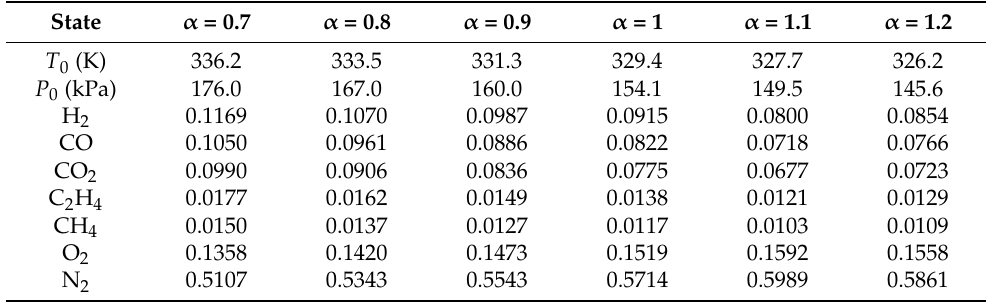
Table 6. Initial states and mole fractions of the combustible mixture for the 2D